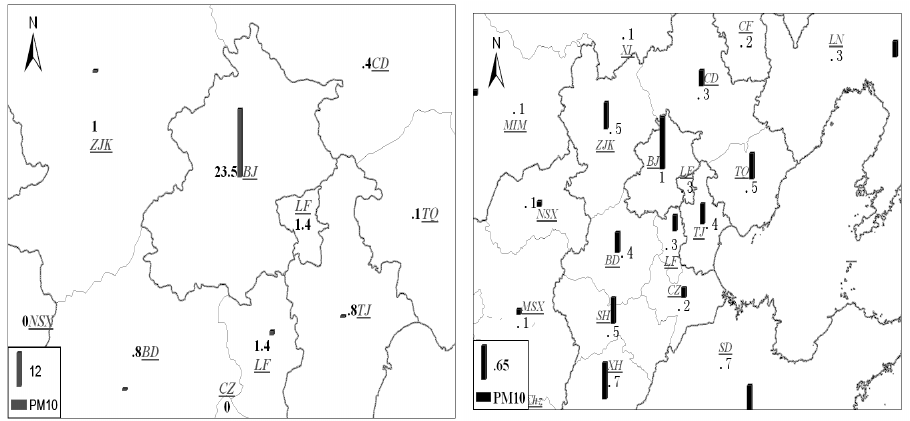
Fig. 8. Same as Fig. 6, but for primary PM 10 . The PM 10 concentration unit is µgm − 3 .